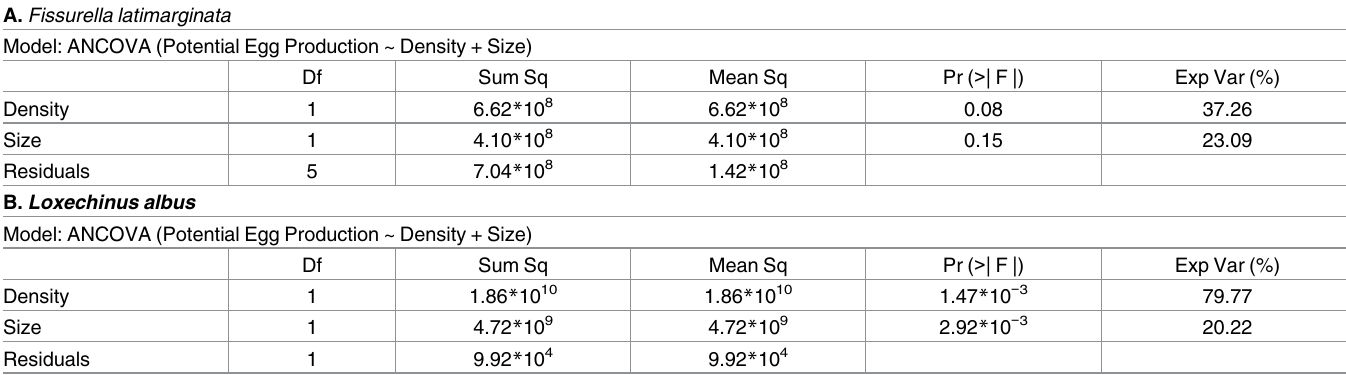
Table 3. Influence of size and density on potential egg production. Statistical results of the effect of density and size on potentialegg